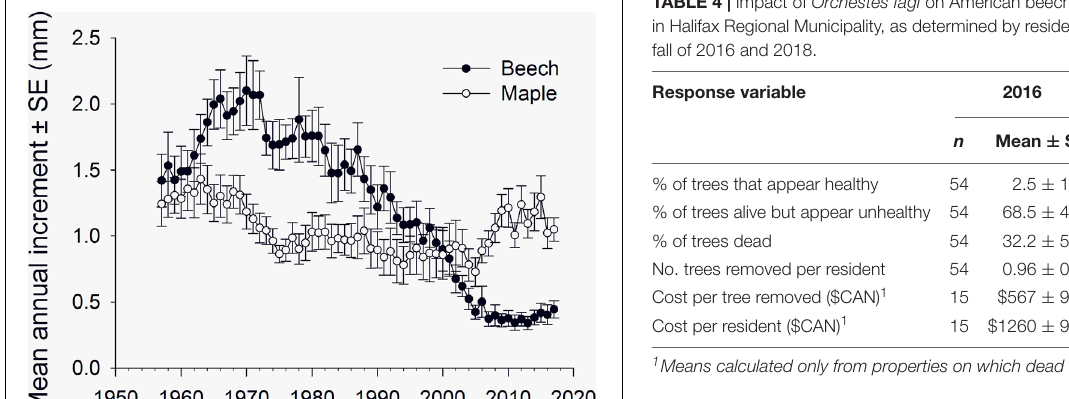
( Table 4 ). Percentage mortality was greater in the neighborhoods of Fairmount (36.9 ± 6.8) and Kent (35.3 ± 10.2) than in Fall